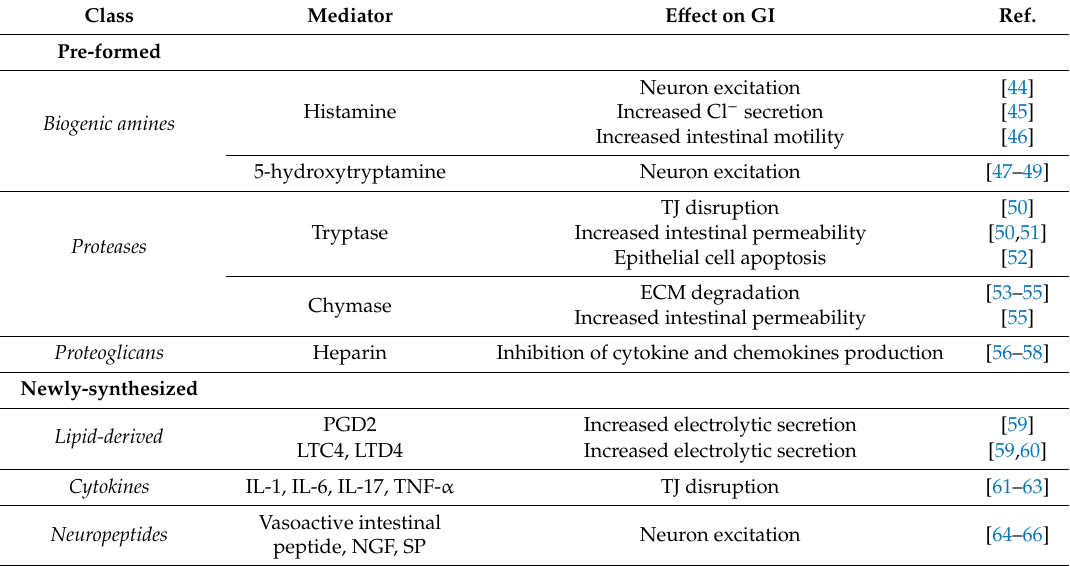
Table 2. Major MC-derived mediators and their e ff ect on gastrointestinal (GI)